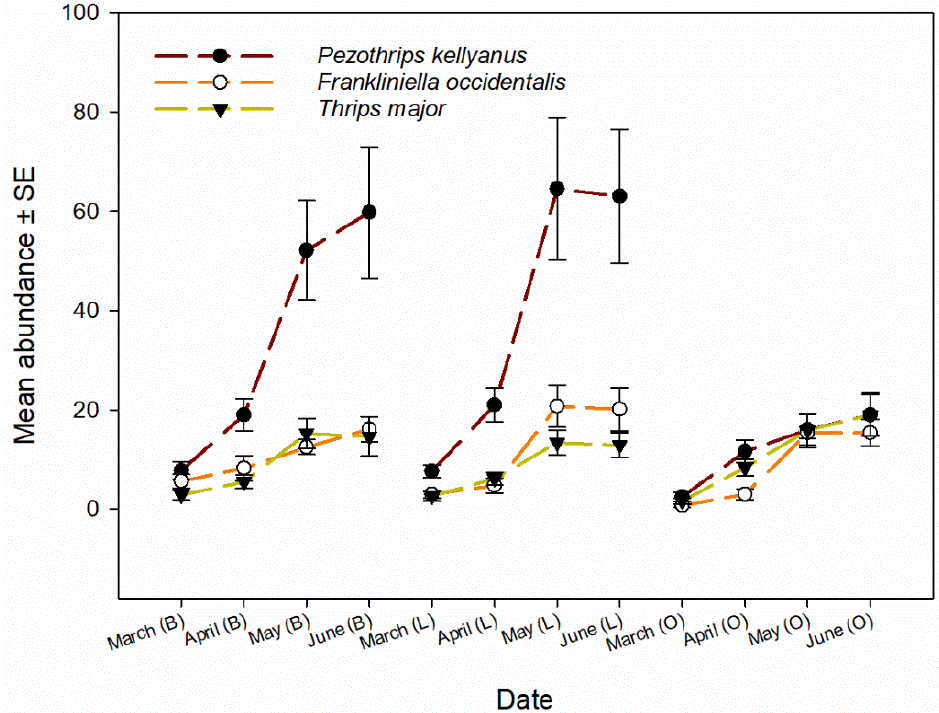
Figure 4. Abundance and seasonal distribution of monitored thrips species in different citrus fields (B = bergamot, L= lemon and O = orange).